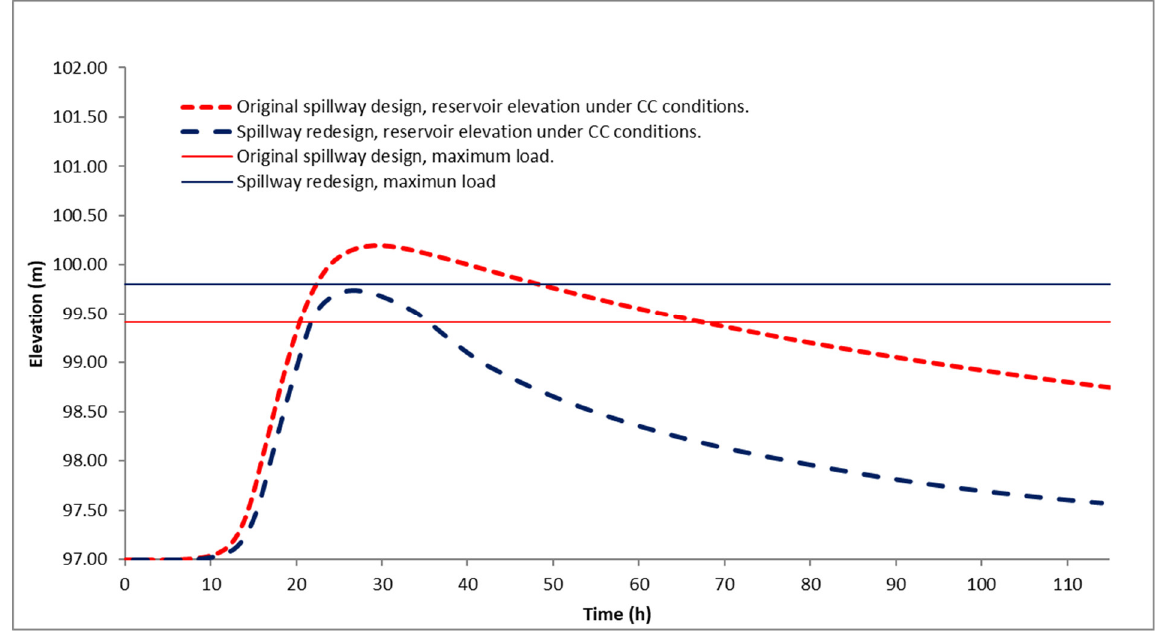
Figure 10. Comparison of reservoir levels with maximum flood for the Sube y Baja